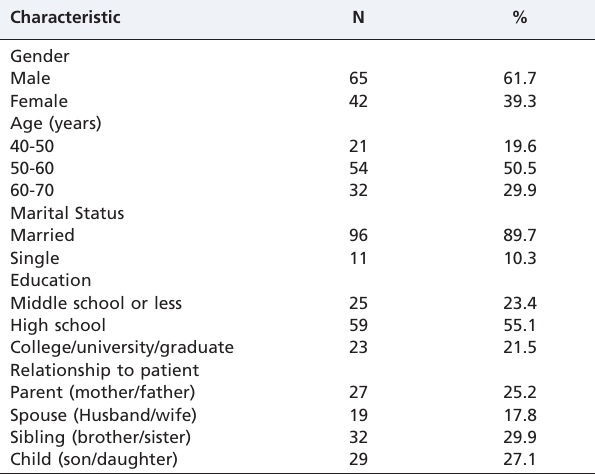
Table 1 - Characteristics of the family members of patients in a vegetative state (n=